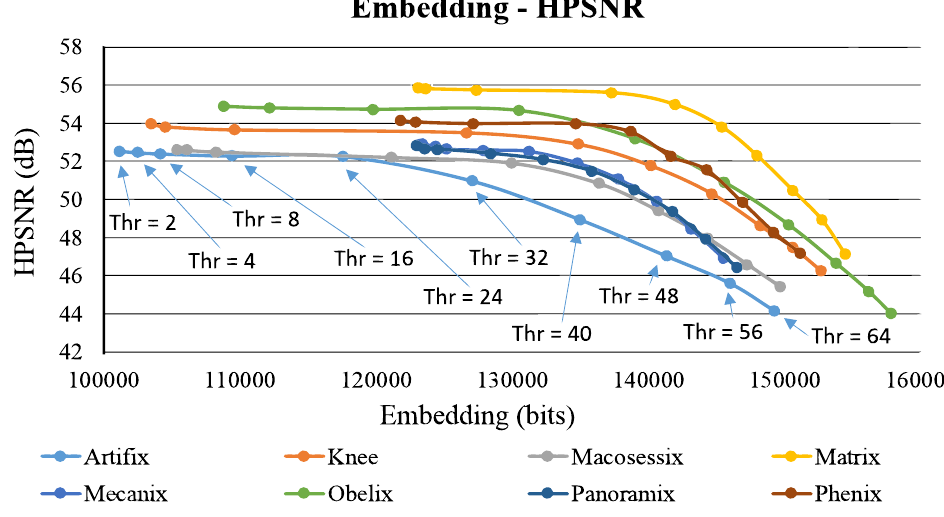
Figure 9. Results of self-evaluation using different threshold values in terms of embedding capacity versus HPSNR.